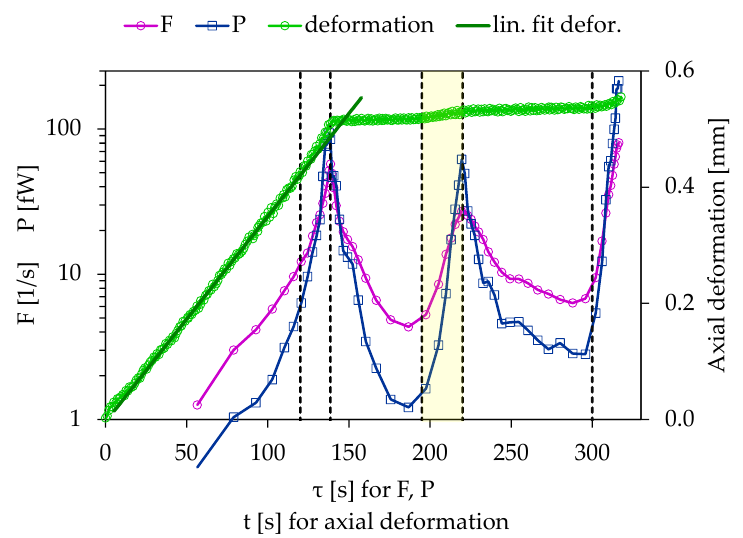
Figure 4. Temporal evolution of the F - and P -functions in juxtaposition with the axial mechanical deformation.